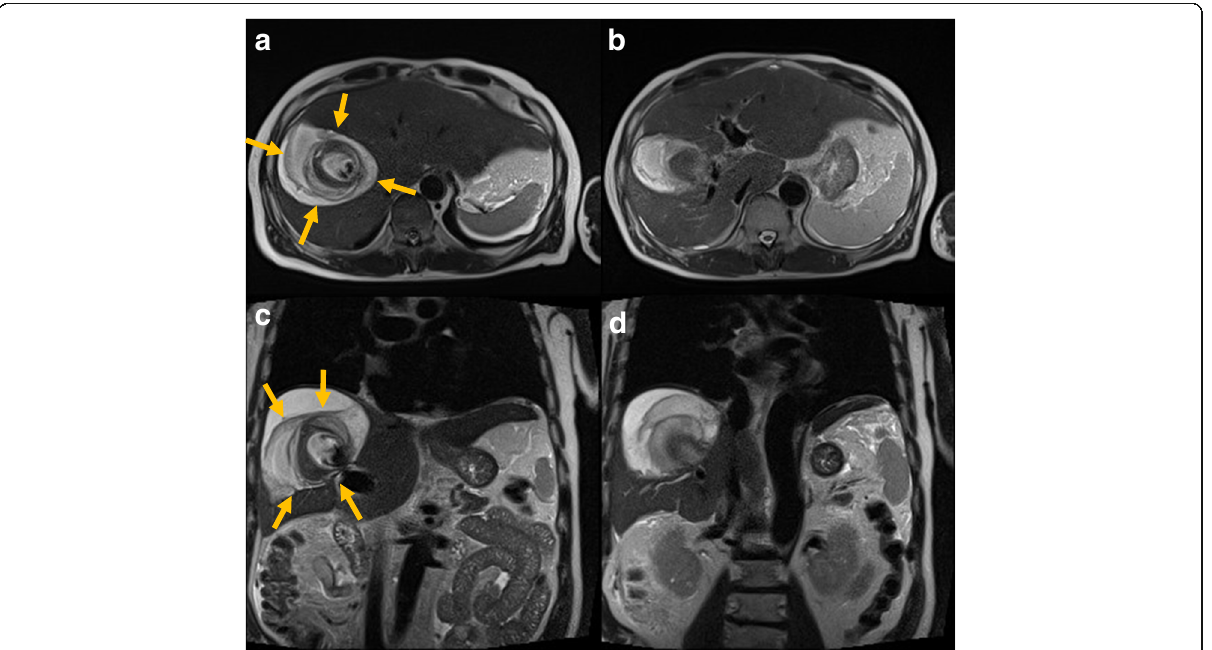
Fig. 4 Dynamic MRI findings 3 months after surgery. a , b Axial images of dynamic MRI. c , d Coronal images of dynamic MRI. An arterioportal fistula and portal vein aneurysm were incidentally detected. Layers of old and subacute hematomas were clearly observed, and these layers surrounded the aneurysm ( arrows ) . We suspected a pseudoaneurysm based on these MRI